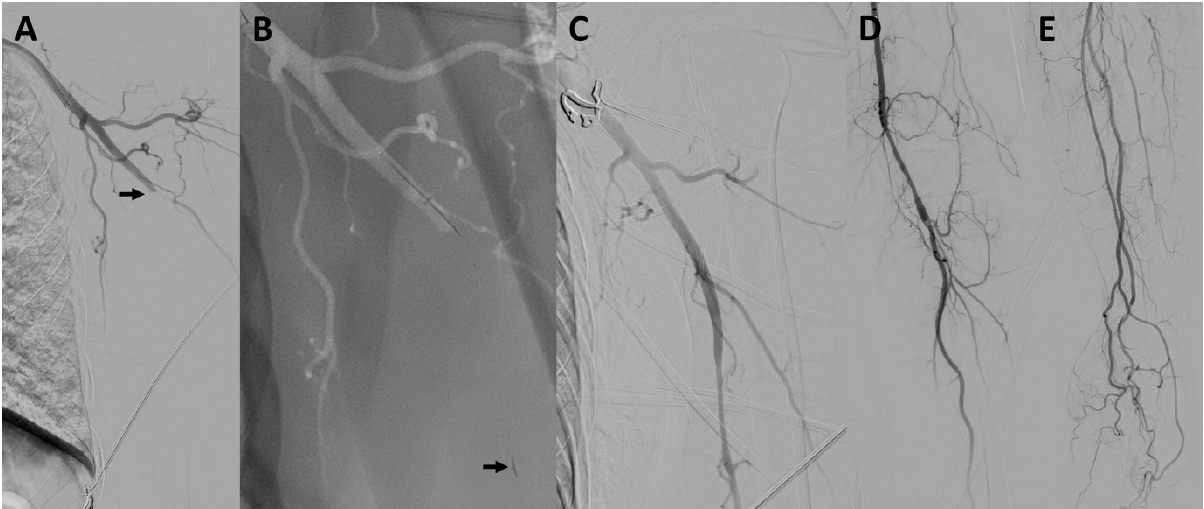
Figure 3. Mechanical thrombectomy of concomitant occlusions of the left carotid T and the axillary artery. Patient #6 pre- sented with an occlusion of the carotid T, which could be successfully recanalized with one thrombectomy maneuver (not shown). Digital subtraction angiography showed a concomitant occlusion of the left axillary artery (arrow in ( A )). A mi- crowire/microcatheter was navigated into the occluded vessel and an Embo Trap II 5 × 33 mm stent retriever was deployed within the occlusion (arrow pointing at the distal tip of the stent retriever in ( B )). The occlusion was successfully re- canalized with one stent retriever maneuver without any residual occlusion ( C – E ).